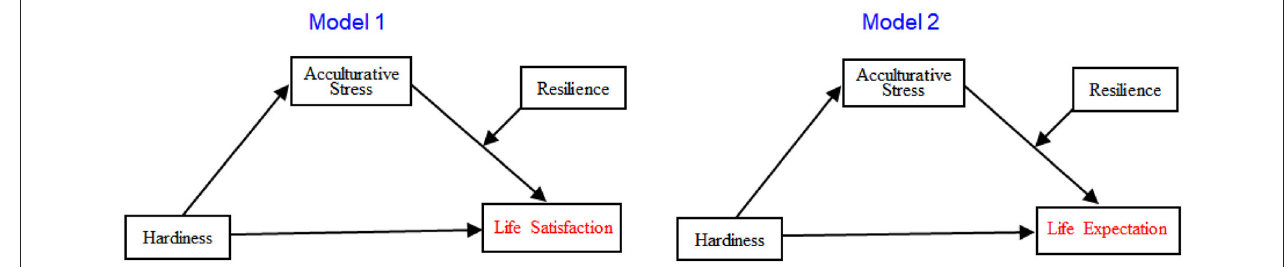
FIGURE 1 | Moderated mediation models of this